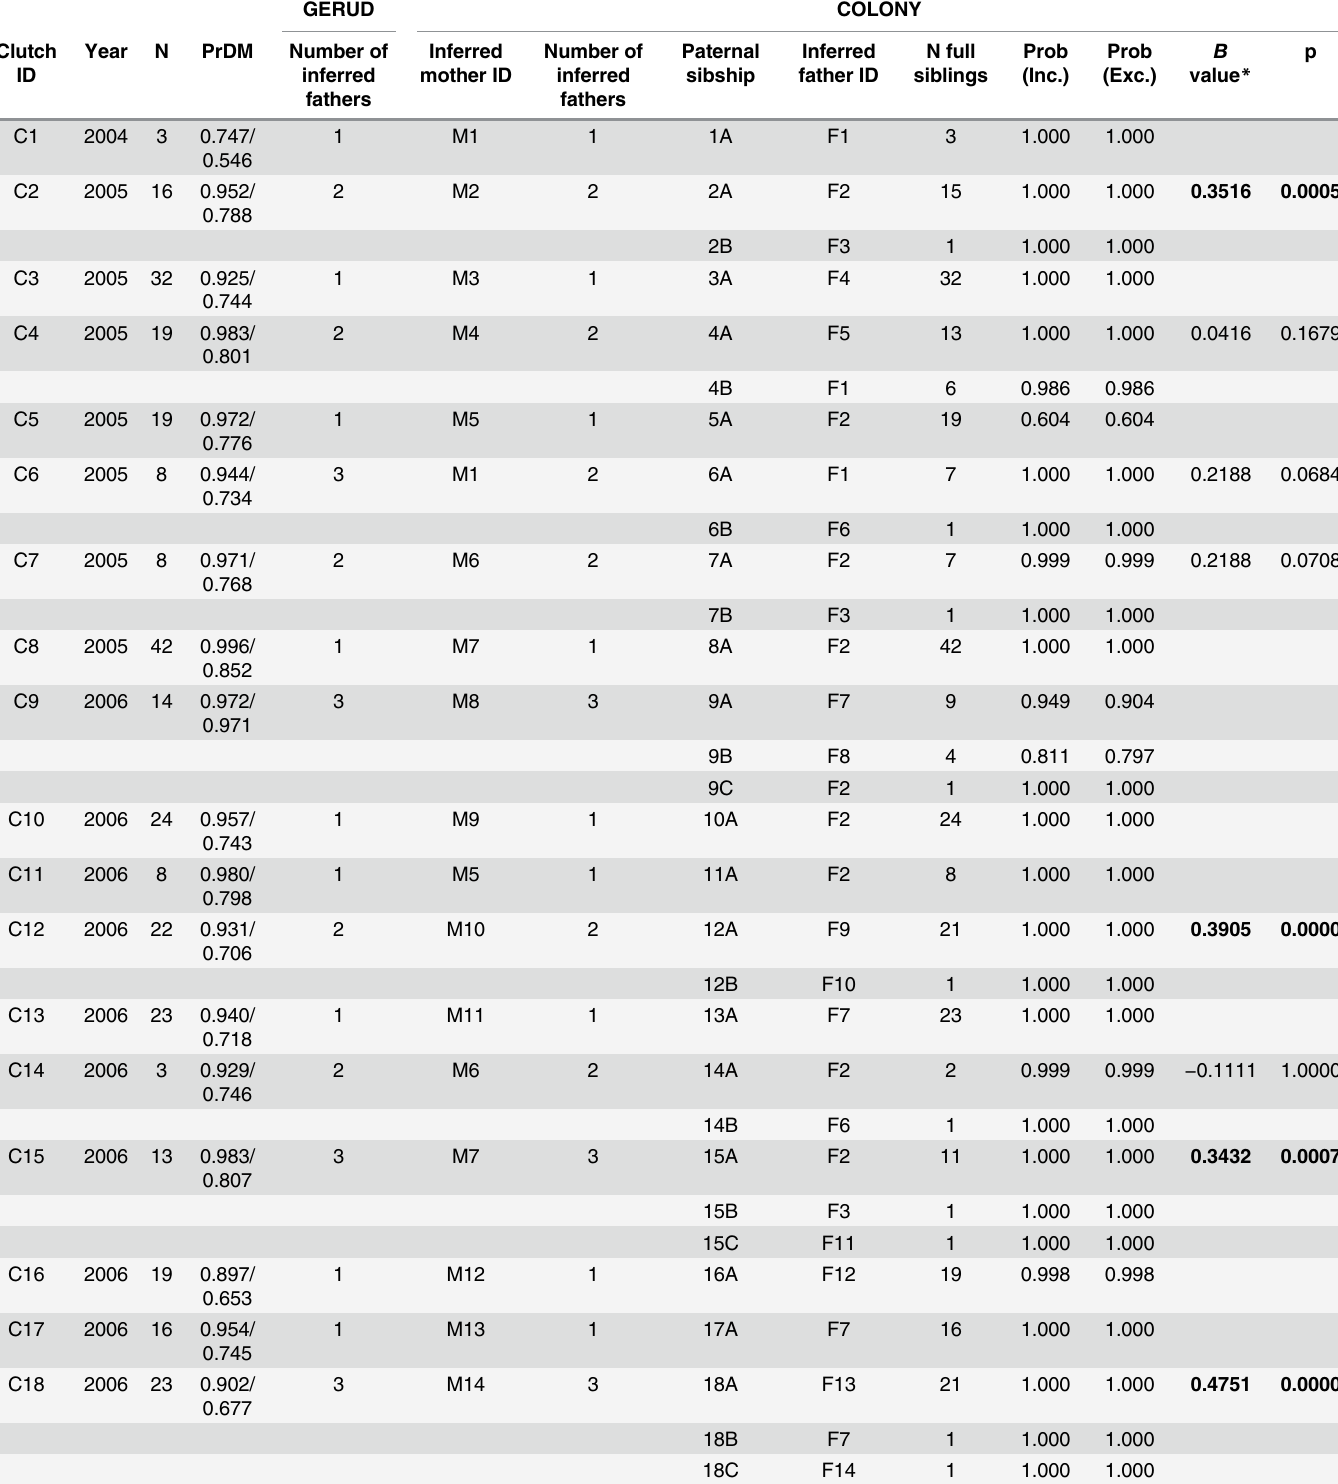
Table 2. Paternity analyses for 20 clutches of Crocodylus intermedius from the El Frío Biological Station, Venezuela. GERUD